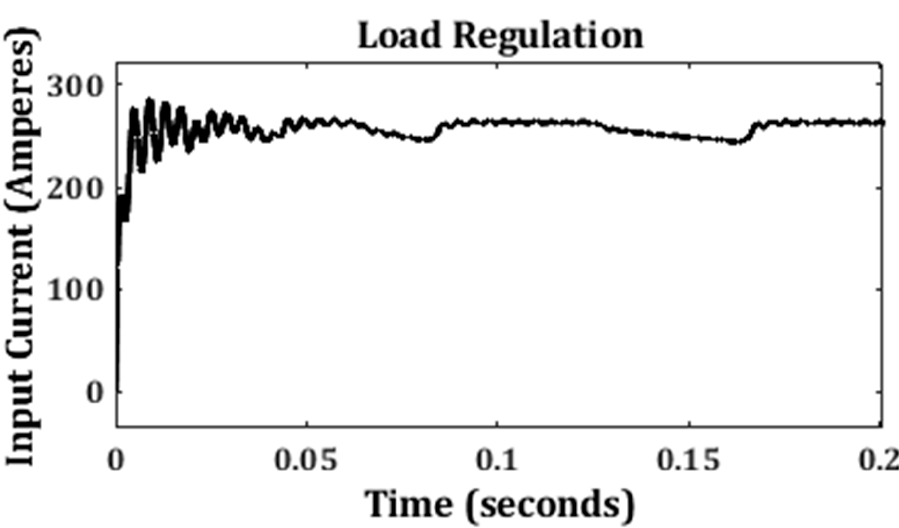
Figure 48. Input current in Amperes during load regulation.